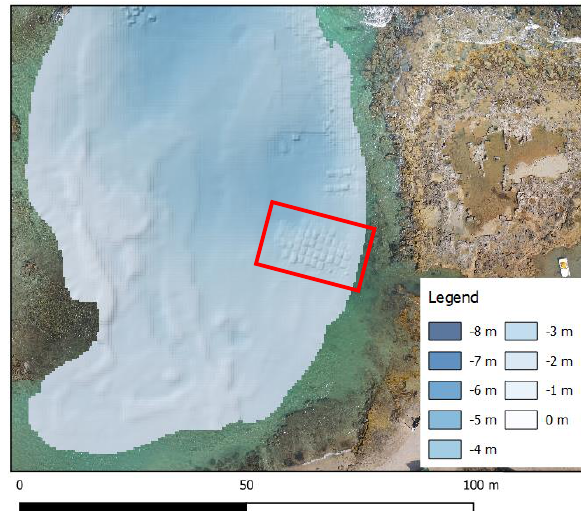
Figure 12 . DEM of the seabed of Baia dei Camerini obtained after the multi-beam survey; in red, the concrete blocks that protect the roman shipwreck's archaeological site area.